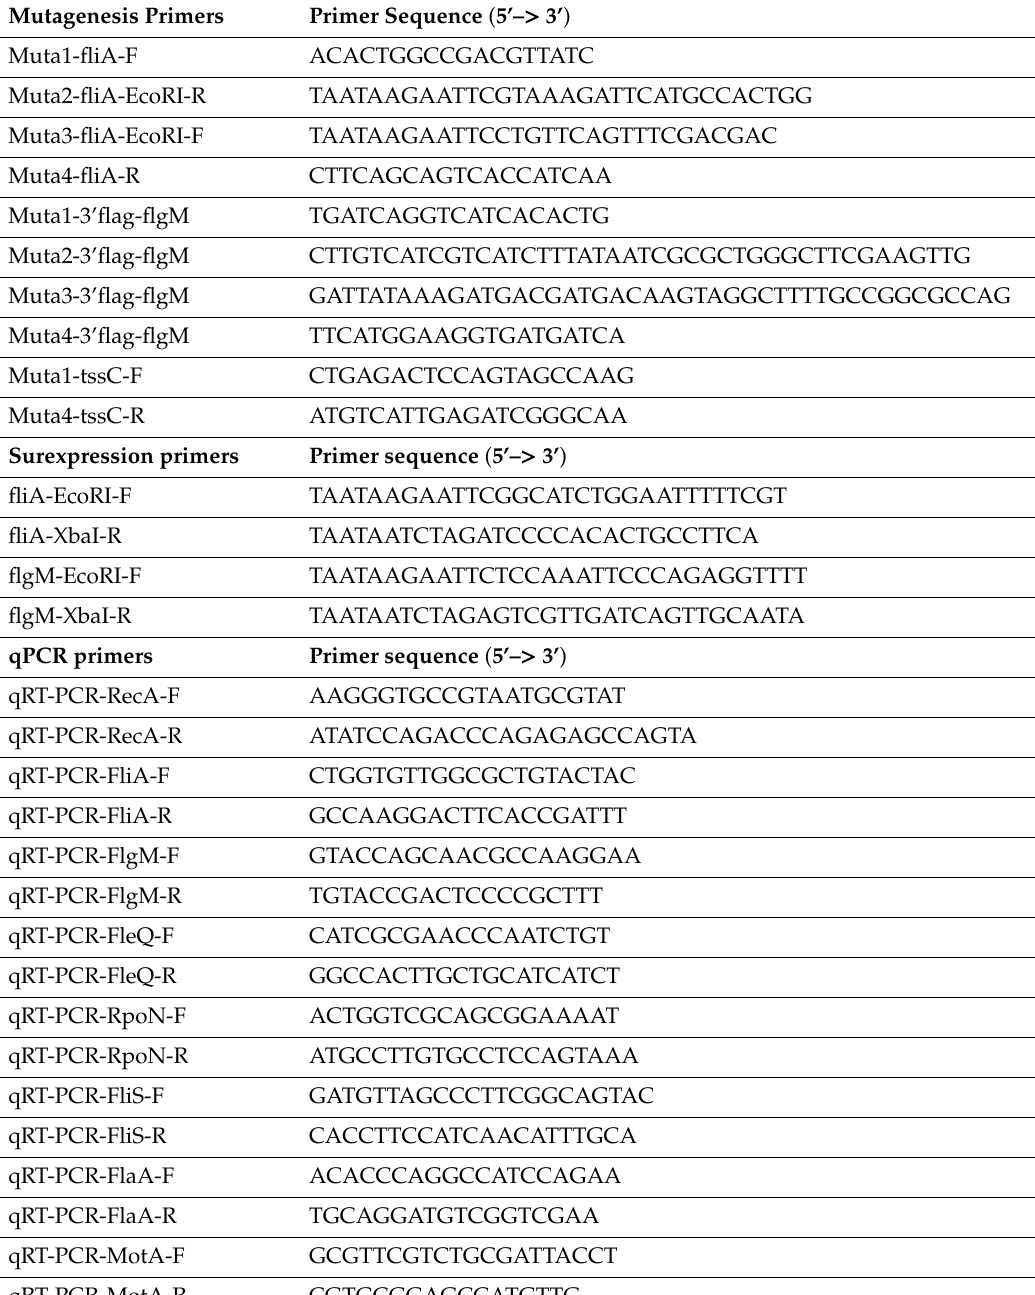
Table 2. Oligonucleotides used in this study. The underlined sequences correspond to the flag sequence. Mutagenesis